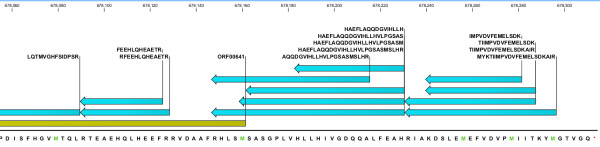
Correcting start site assignment for ORF00641. Multiple peptides (green bars) map upstream of the predicted ORF00641 (yellow bar) including several peptides that spans the currently predicted gene start, providing evidence in support of extending the start site. The in-frame * symbol represents the stop codon TAA.